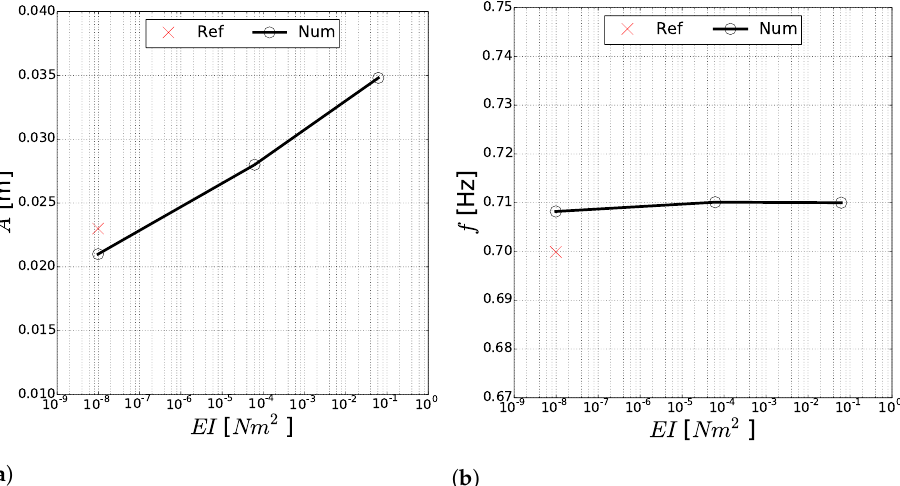
Figure 22. Parameter study of the effects of EI on the ( a ) amplitude and ( b ) frequency of the surge motion.